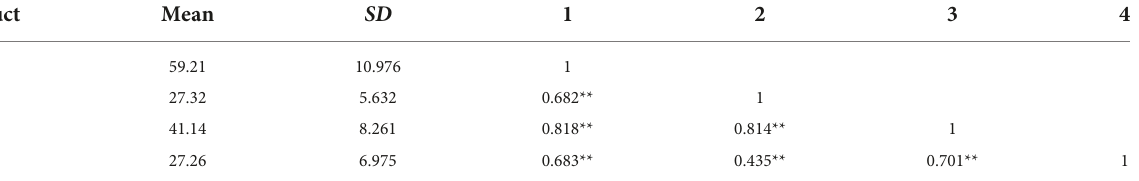
TABLE 3 Mean, standard deviation, and